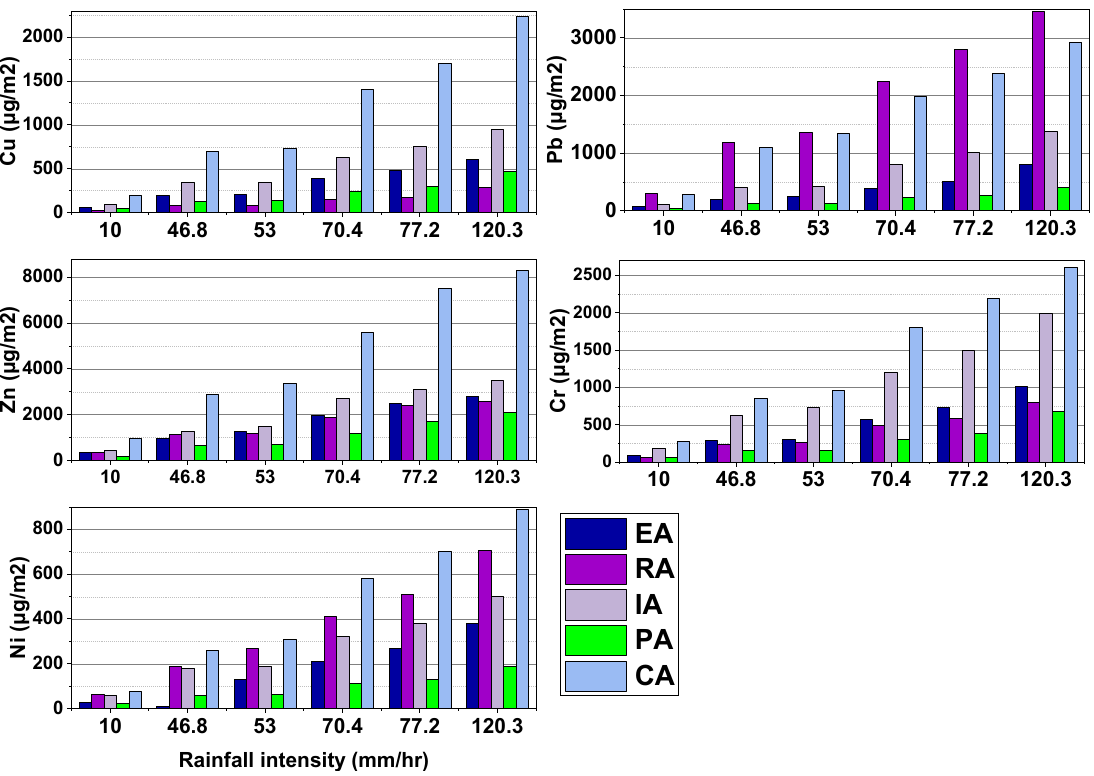
Figure 4. Potential pollution contributions to runoff per unit area ( μ g/m 2 ) .